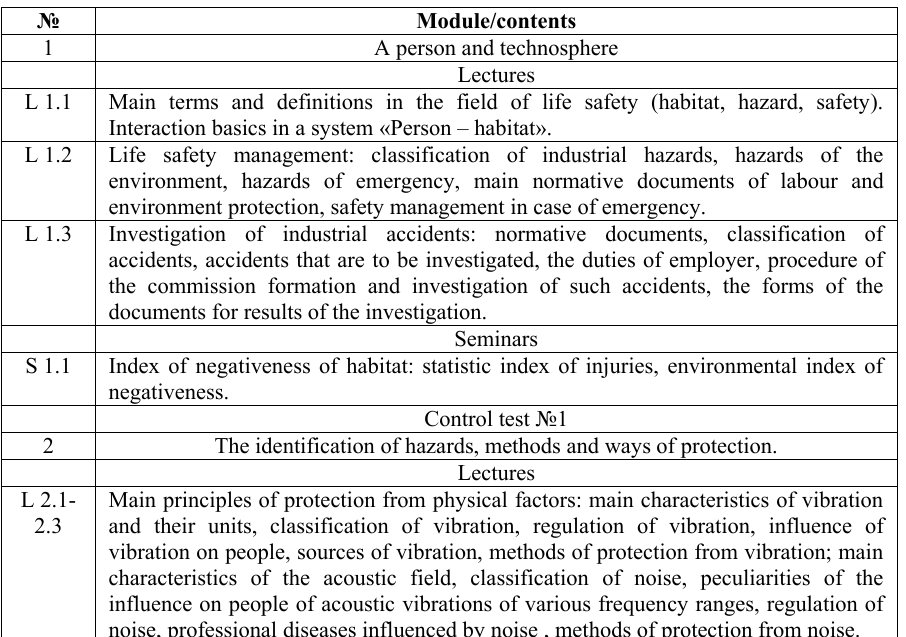
Table 1. The contents of the discipline «Life